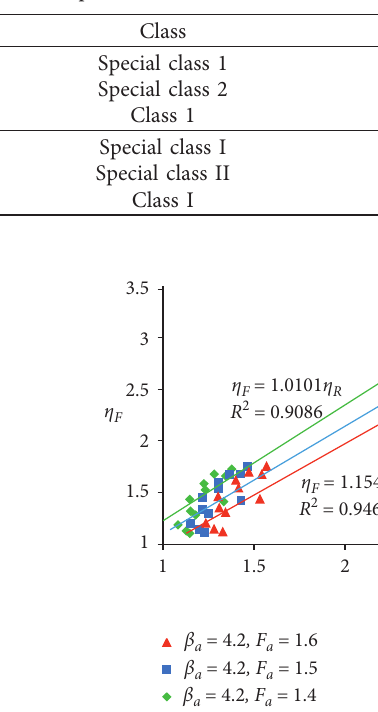
Table 8: Proposed value of risk control standards for stability of special dam and slope.